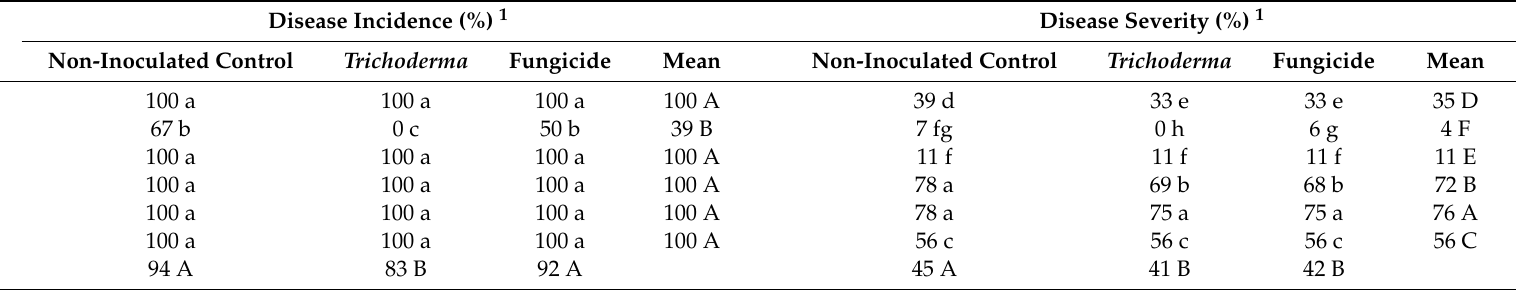
Table 1. Means of disease parameters under low- fertilization regime of six Jerusalem artichoke genotypes and three control